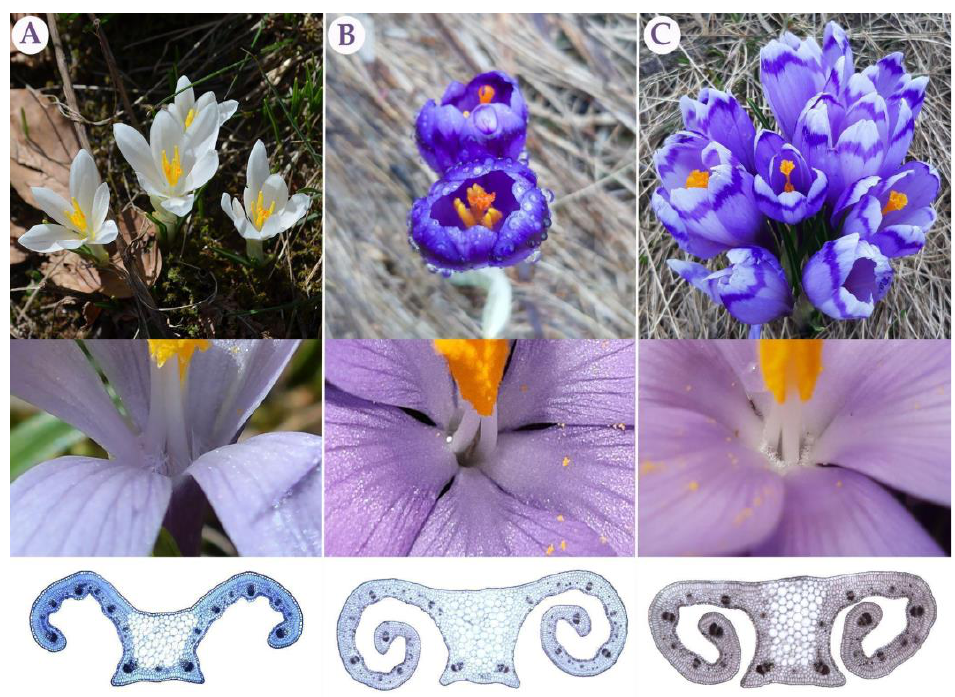
Figure 7. Flower, throat, and cross-section of leaf (from top to bottom) of parental species and a C. cf. heuffelianus polyploid: C. vernus ( A ), C. heuffelianus ( B ), and polyploid C . cf. heuffelianus representatives ( C ).